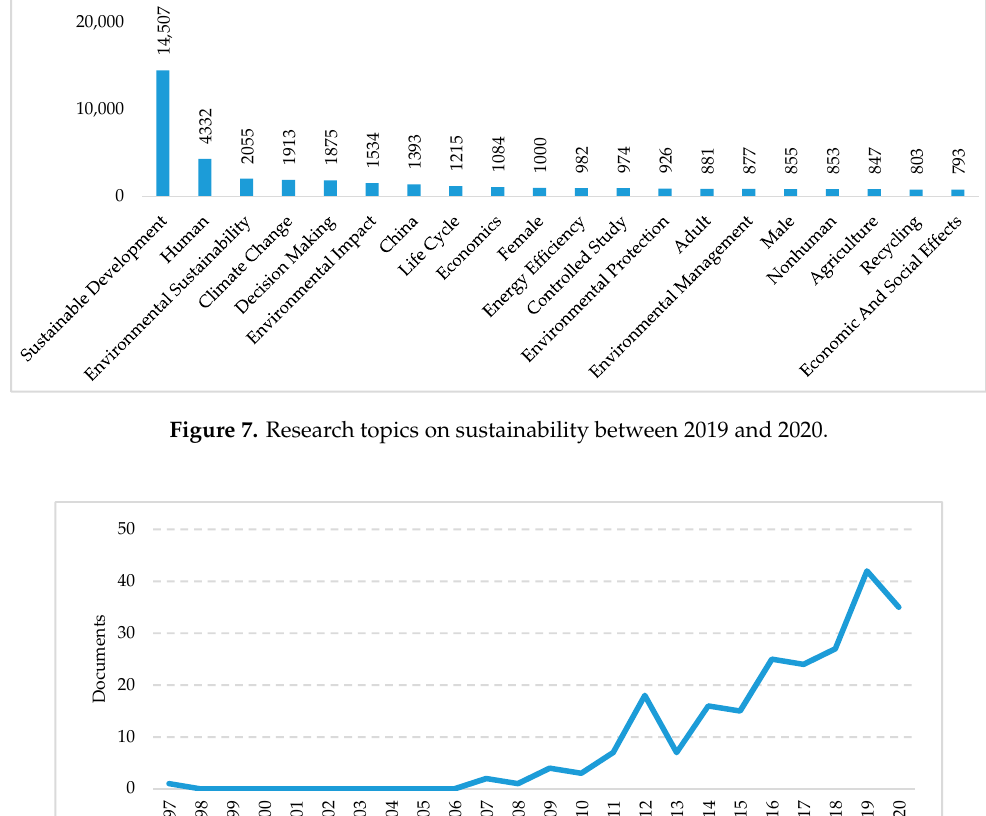
Figure 7. Research topics on sustainability between 2019 and 2020.